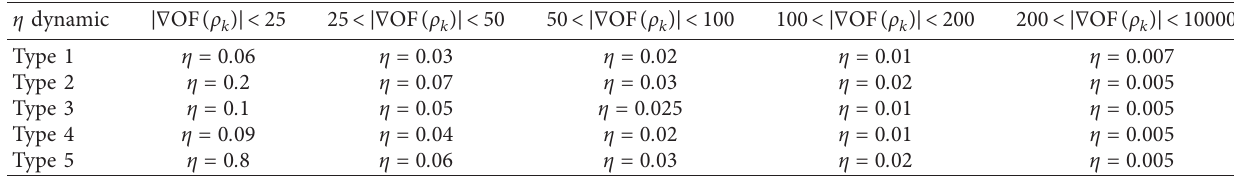
Table 3: Dynamic η values.